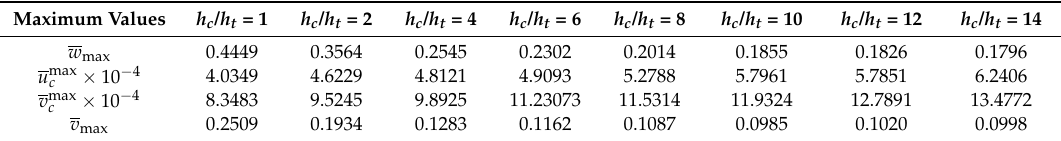
Figure 6. Dynamic deflections of center point of the plate versus time for different ratios h c / h t . ( a ): Nondimensional deflection u c versus time, ( b ): Nondimensional deflection v c versus time, ( c ): Nondimensional velocity w versus time, ( d ): Nondimensional velocity v versus time. Table 4. Maximum deflections and velocities of the plate center point of the plate versus time for different ratios h c / h t .